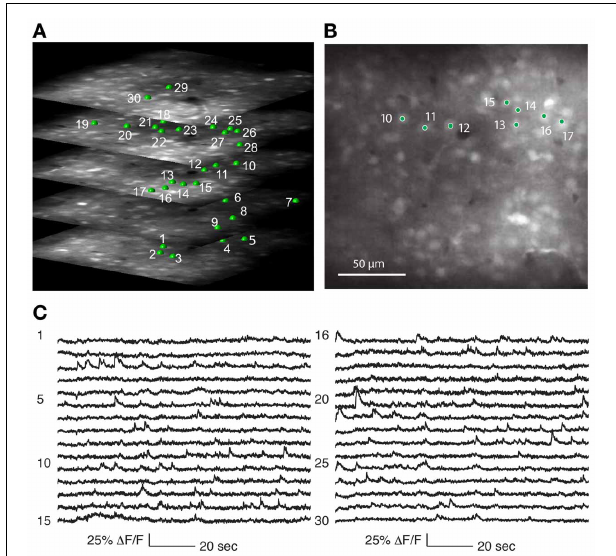
FIGURE 4 | Recording from a population of neurons with 3D-RAMP microscope. (A) A 3D structural image is acquired by sequentially hopping through all the points in a 200 × 200 × 100 μ m volume (250 × 250 × 50 points were acquired). Only a subset of the axial sections is shown. Cells are selected for functional calcium signals from each of the planes in the volume by clicking on the center of the cell bodies. In this data set 133 cells were recorded during spontaneous activity, of which 30 are shown here and are labeled green. (B) A plane from the middle of the stack, demonstrating that cells are clearly visible against the neuropil. (C) Functional calcium signals from 30 out of the 133 cells simultaneously recorded (each with 375Hz sampling rate) are shown with the numbers corresponding to locations marked in (A,B) . Clear calcium transients are visible from the majority of cells. All signals were downsampled to 20Hz for visualization. Signals from all of the 133 cells recorded are shown in Supplementary Figure 2.